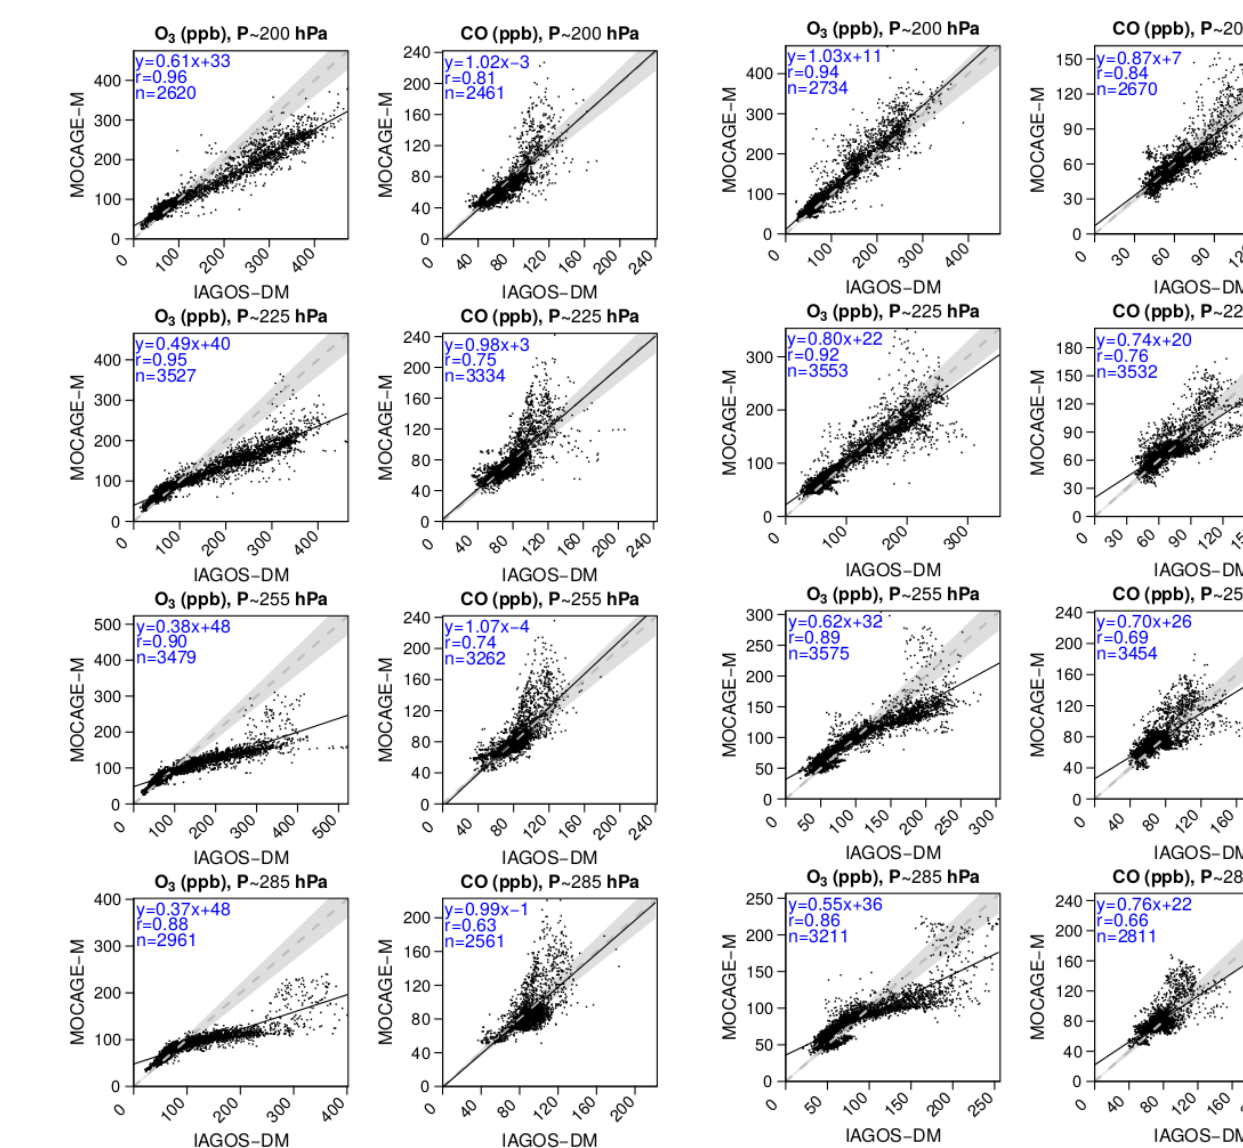
Figure B3. As Fig. 5 for boreal summer. The two extremely high CO values seen by IAGOS-DM above Alaska at level 25 (350 and 510ppb) in Fig. A7 have been excluded from the scatterplots be- cause they were considered outliers.